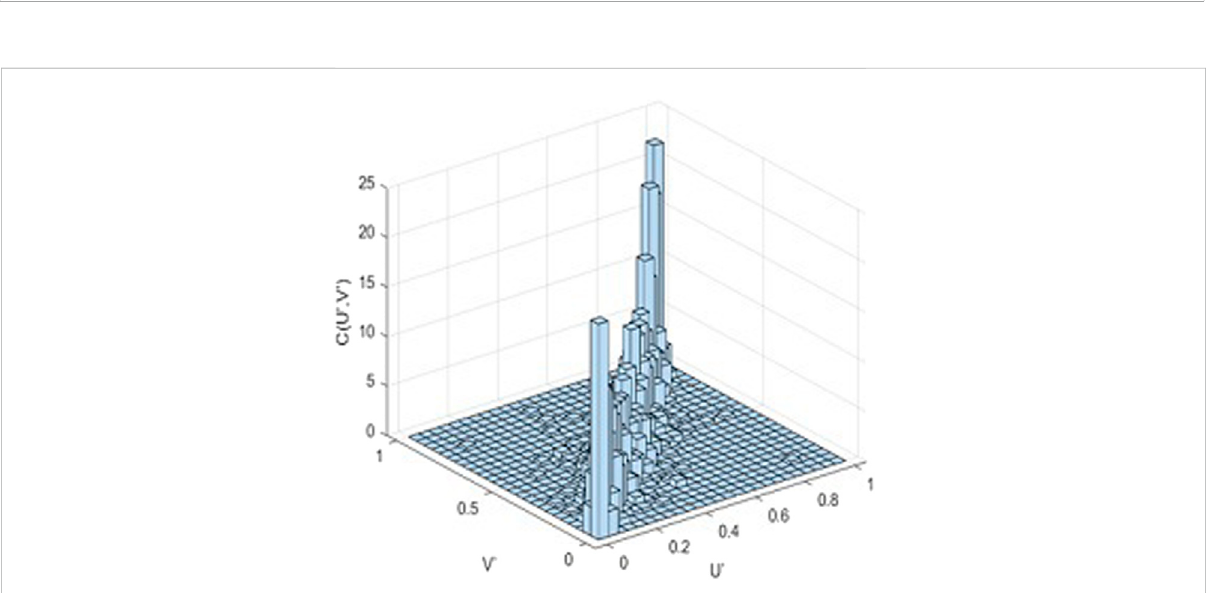
FIGURE 5 BivariatefrequencyhistogramofdailyyieldseriesinSMMNickelandthespotprice.Note:Theindicator U ′ istheedgedistributionofLMENickel futures. The indicator V ′ is the edge dis tribution of the spot price. C (U ′ , V ′ ) represents a joint distribution